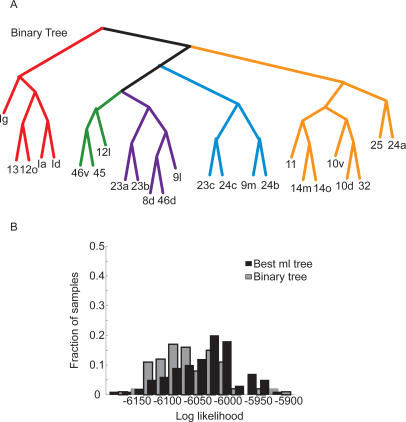
Fit of binary tree.(A) Tree which best fit the binary data. (B) Comparison of fit of binary tree and tree fit to weighted data, on the weighted dataset.